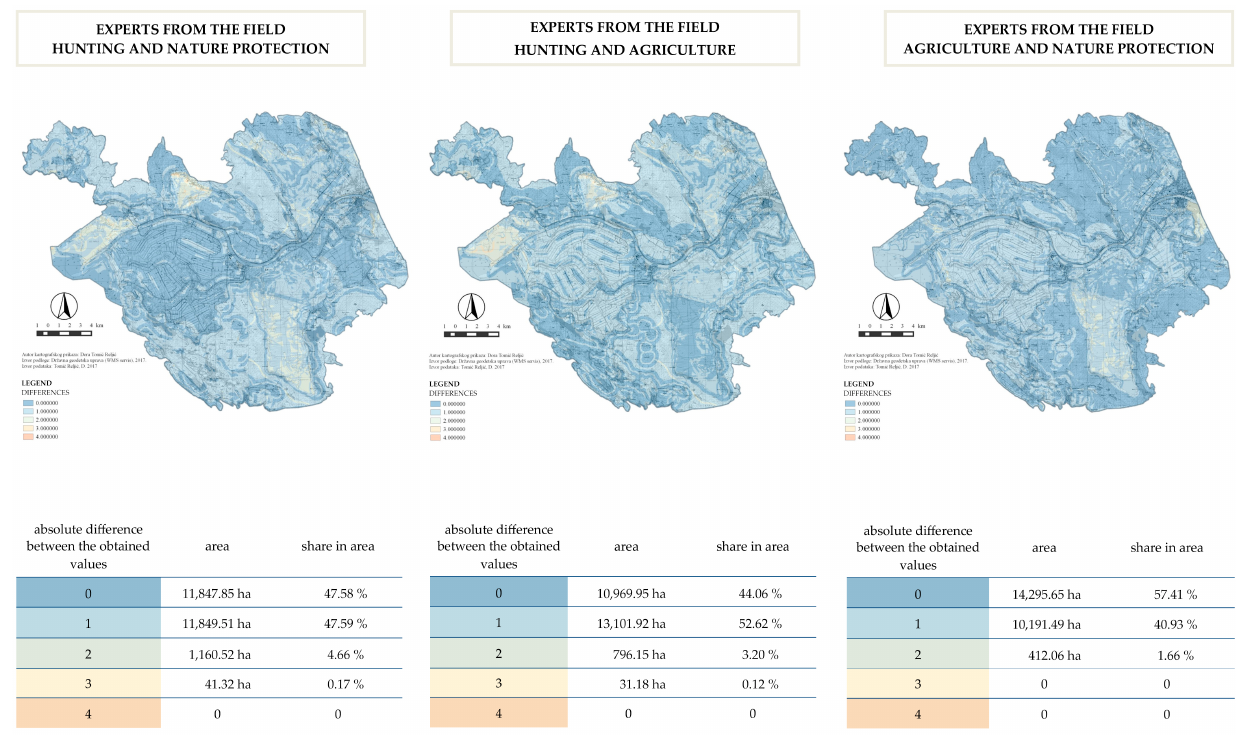
Figure 6. Cross-tabulation maps and matrices .